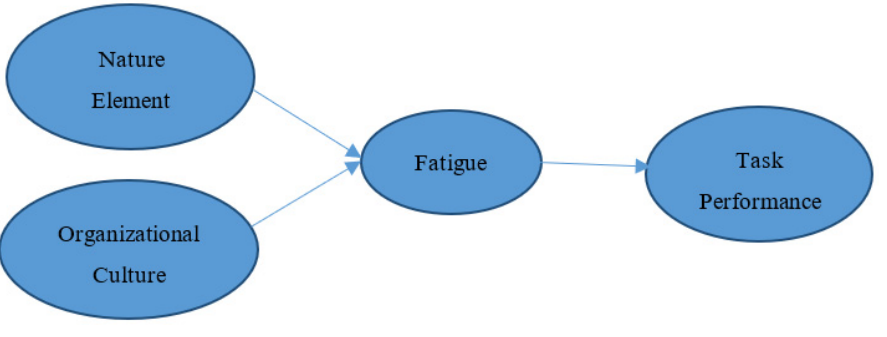
Figure 1. Proposed Research Model.